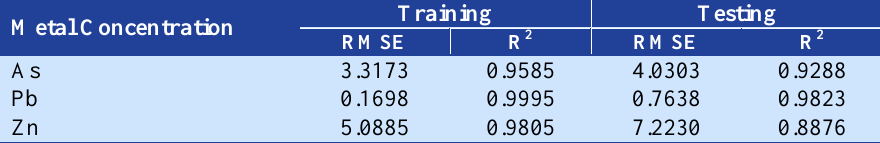
Training Testing RMSE R 2 RMSE R 2